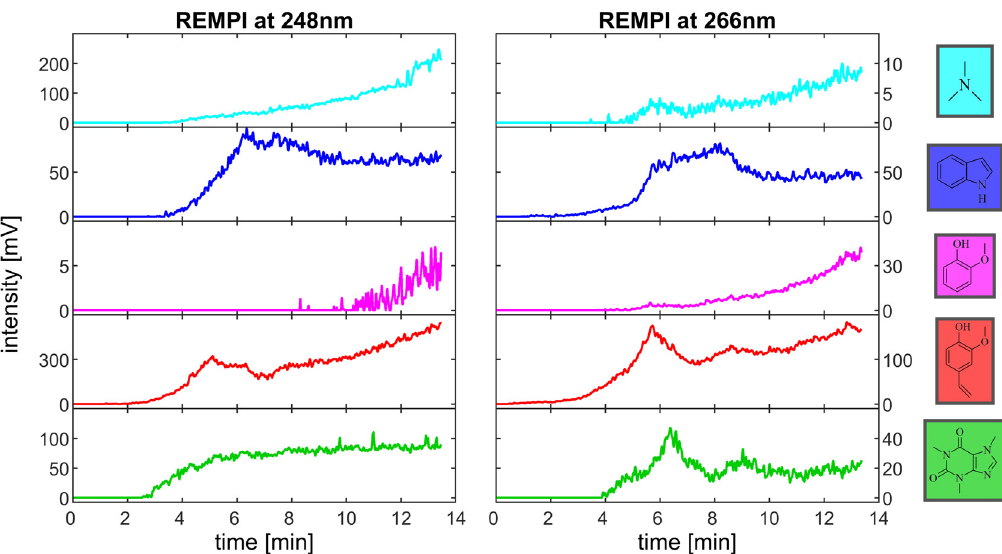
Figure A2. Separated illustration of time traces (1 s time resolution) in Figure 3 for REMPI at 248 nm (left) and REMPI at 266 nm (right) for C3-amine ( m/z 59; cyan), indole ( m/z 117; blue), guaiacol ( m/z 124; magenta), vinylguaiacol ( m/z 150; red) and caffeine ( m/z 194; green). Please note the different y-axis scales.